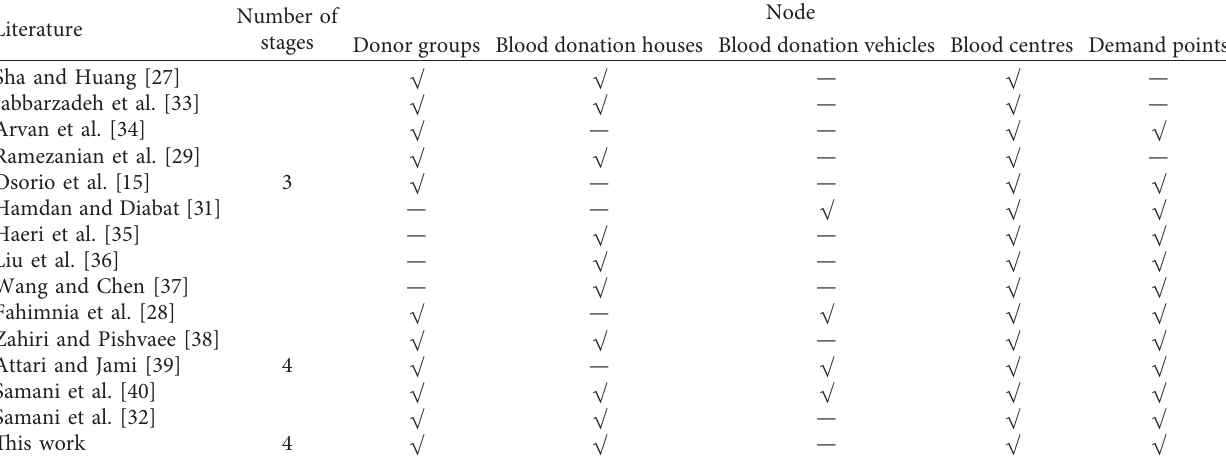
Table 1: Supply chain echelon in some key literature.